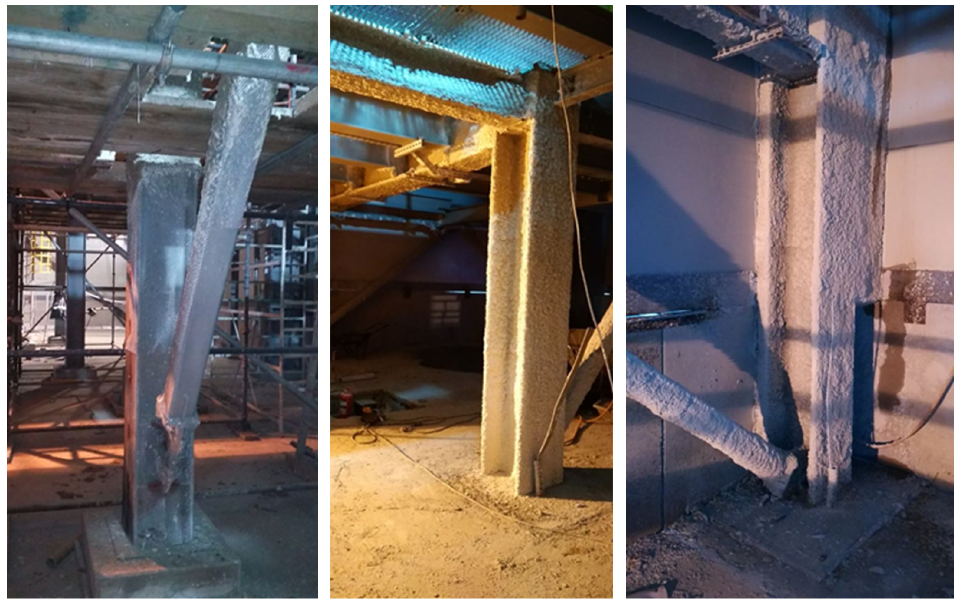
Figure 2. Steel structures with the fireproofing plaster compositions.